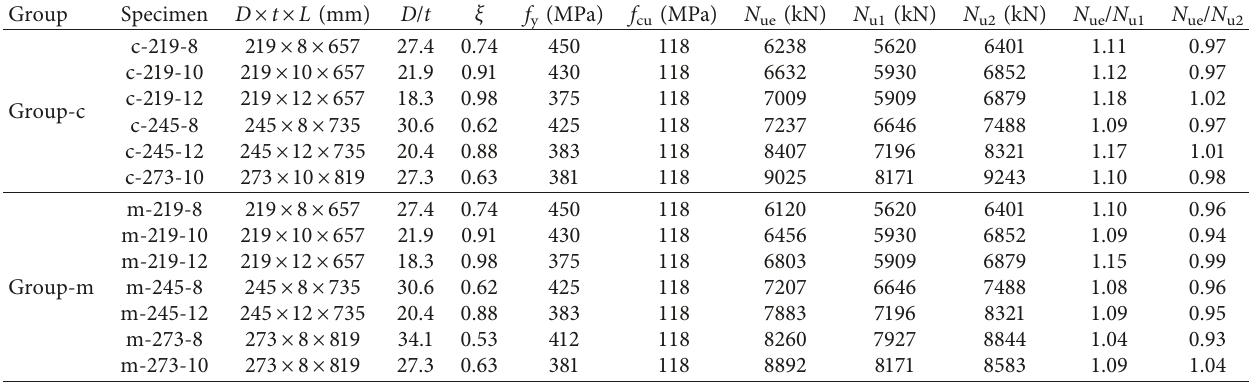
Table 1: Summary of test parameters of